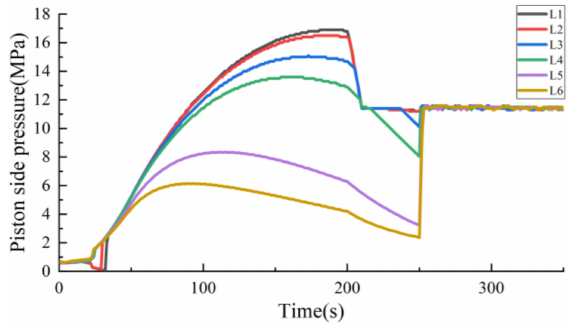
Figure 20. Piston side pressure of different leakage flow.